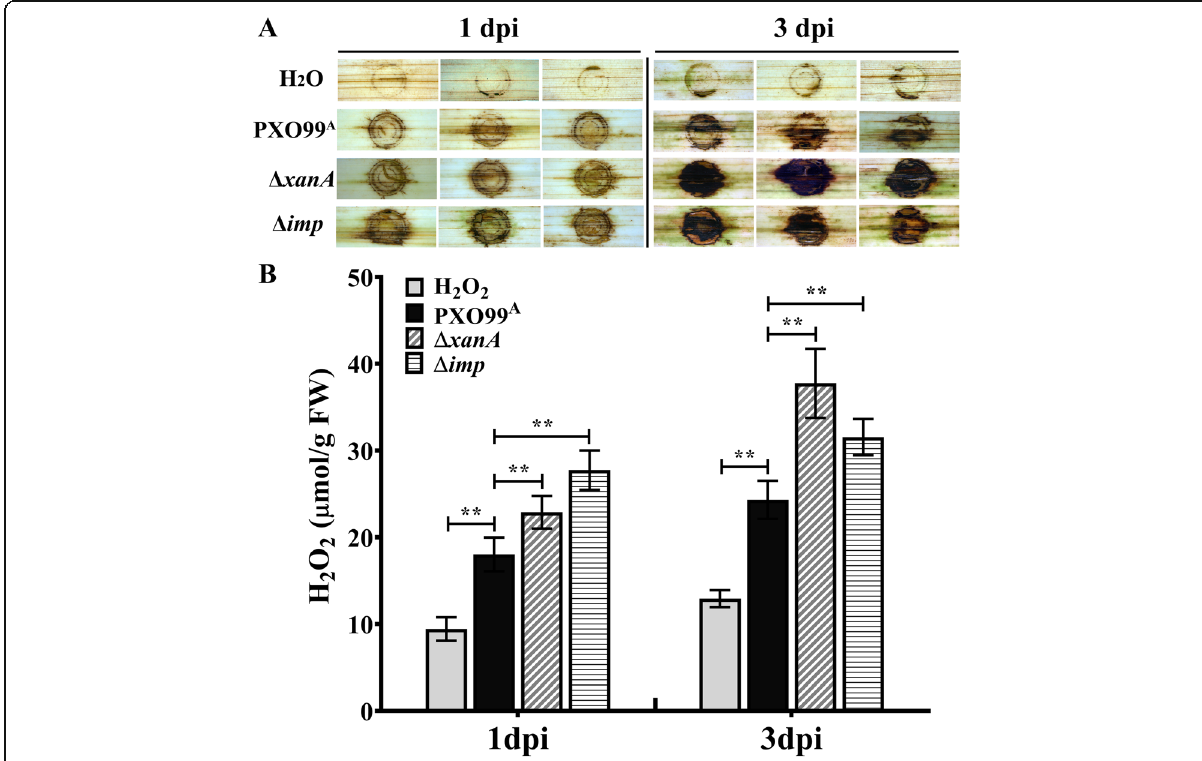
Fig. 3 Detection and assessment of cellular defense responses in rice IR24 at 1 and 3 d after infection with PXO99 A , Δ xanA or Δ imp . A DAB staining and visualization of hydrogen peroxide in IR24 rice. 5-week-old rice leaves were detached and infiltrated with DAB staining solution (1 mg/mL, pH 3.8) used for oxidative burst detection after inoculation with H 2 O, PXO99 A , Δ xanA and Δ imp via 1-ml needleless syringes. PXO99 A - inoculated leaves were used as controls. Orange-brown deposits were visualized after the leaves were cleared in absolute ethanol. Representative photos were taken at 1 and 3 dpi. B Quantification of H 2 O 2 levels in rice leaves after inoculation with H 2 O, PXO99 A , Δ xanA and Δ imp via 1-ml needleless syringes. Values are the means and standard deviation of three independent experiments, each of which comprised two replicates. Asterisks indicate significant differences compared with controls (t test, ** indicates P <